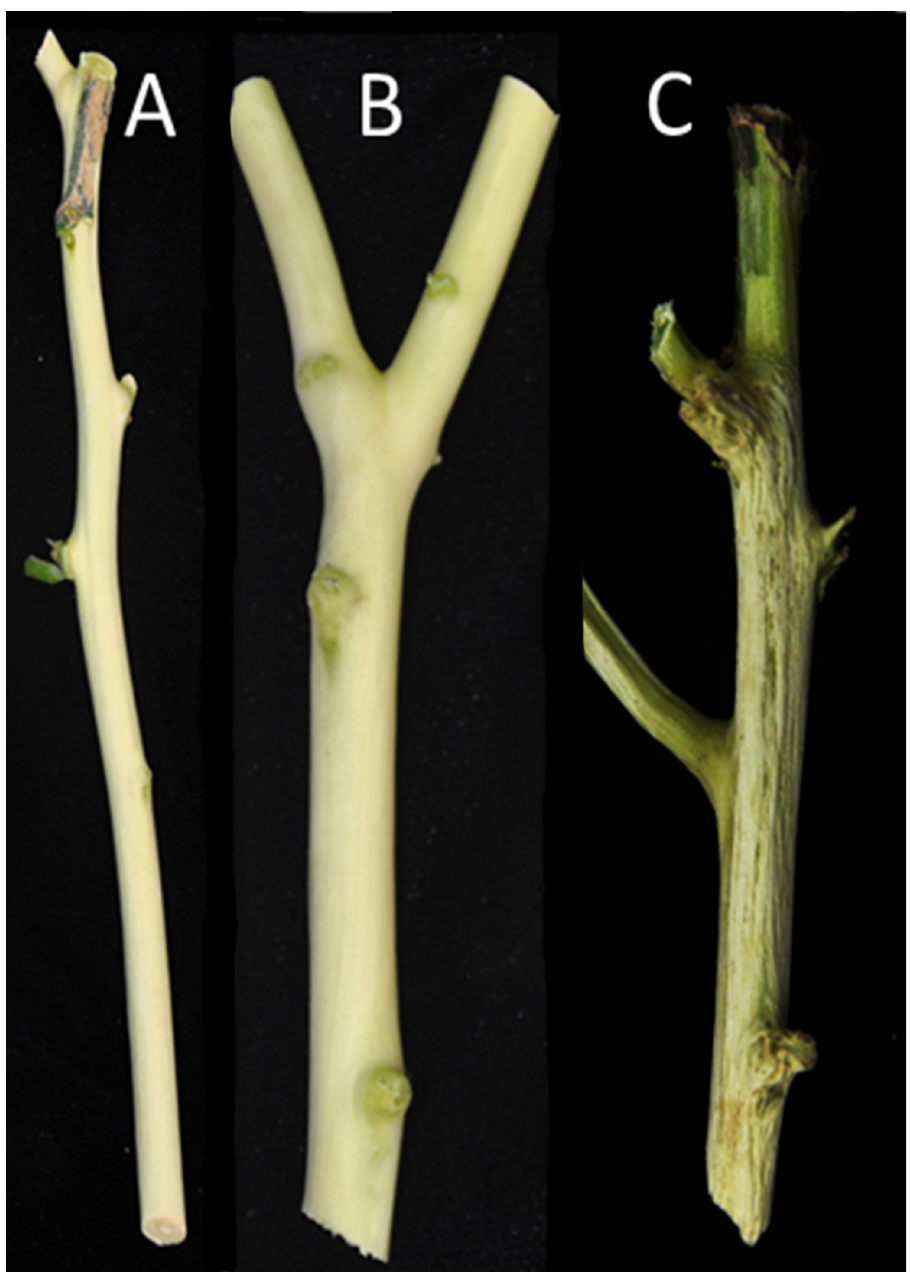
Fig 1. Comparison of citrus tristeza virus (CTV) strain virulence shown by stem pitting (SP) symptoms in Washington navel. A) Healthy controls, B) T36-mild with no SP, and C) VT SY568 severe with strong SP and necrosis. Virulence of SP varied seasonally with new growth